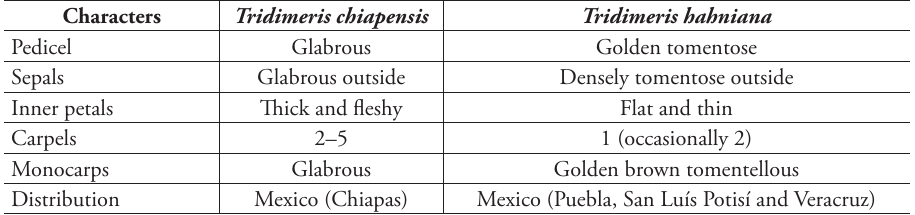
Table 1. Comparison of diagnostic morphological characters of Tridimeris chiapensis and Tridimeris hahniana